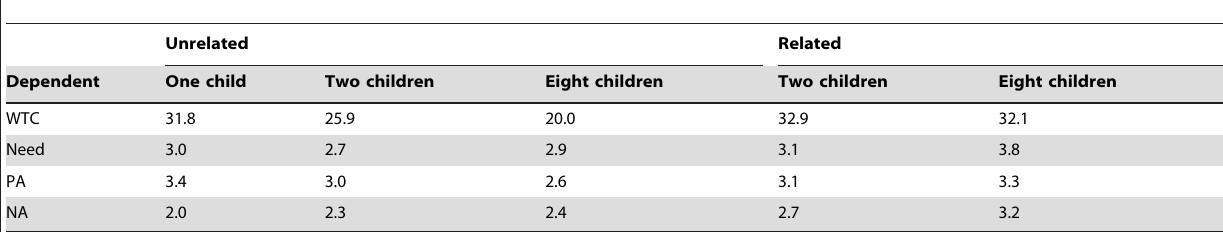
Table 1. Mean WTC, Need, and Positive Affect (PA) and Negative Affect (NA) (Study 3).